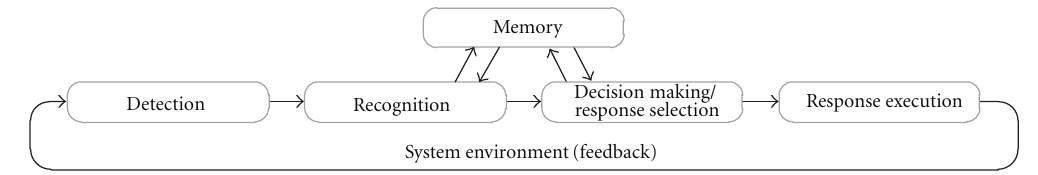
Figure 3: Generic stages of human control in